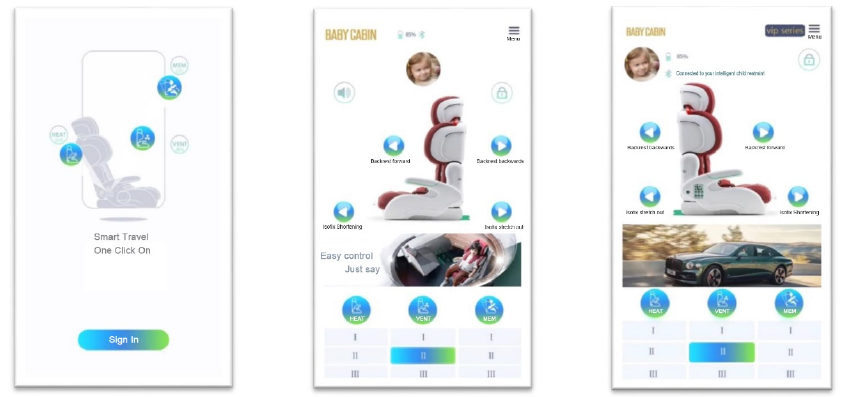
Figure 8. It can be controlled using a cell phone APP.